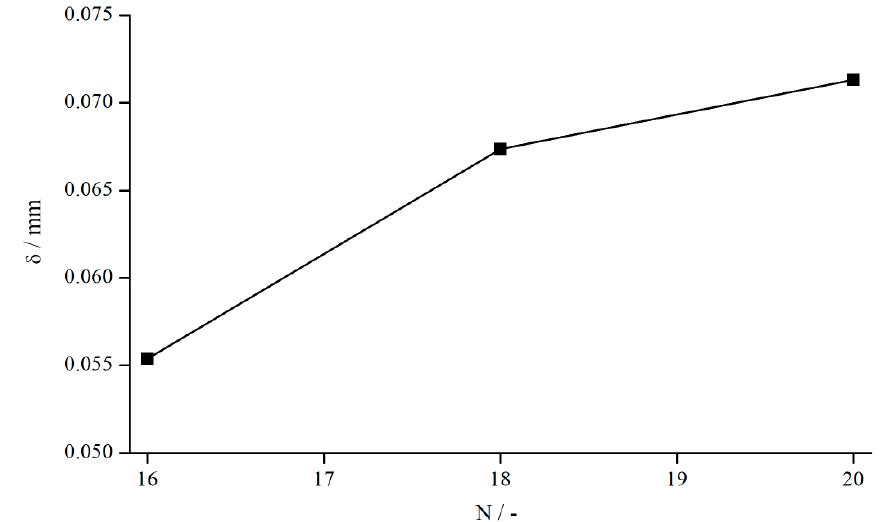
Figure 18. Influence of number of bars (systems 15, 17, and 18) on 𝛿 , measured at 𝛾(cid:4662) = 5.05 1/s .